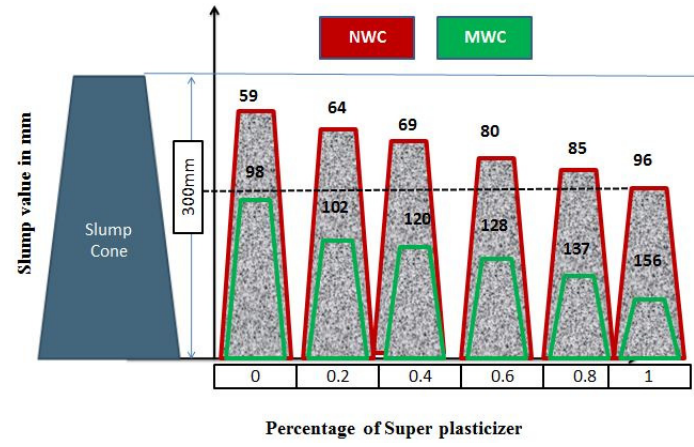
Figure 5. Slump values of NW and MW with 1% of SP.